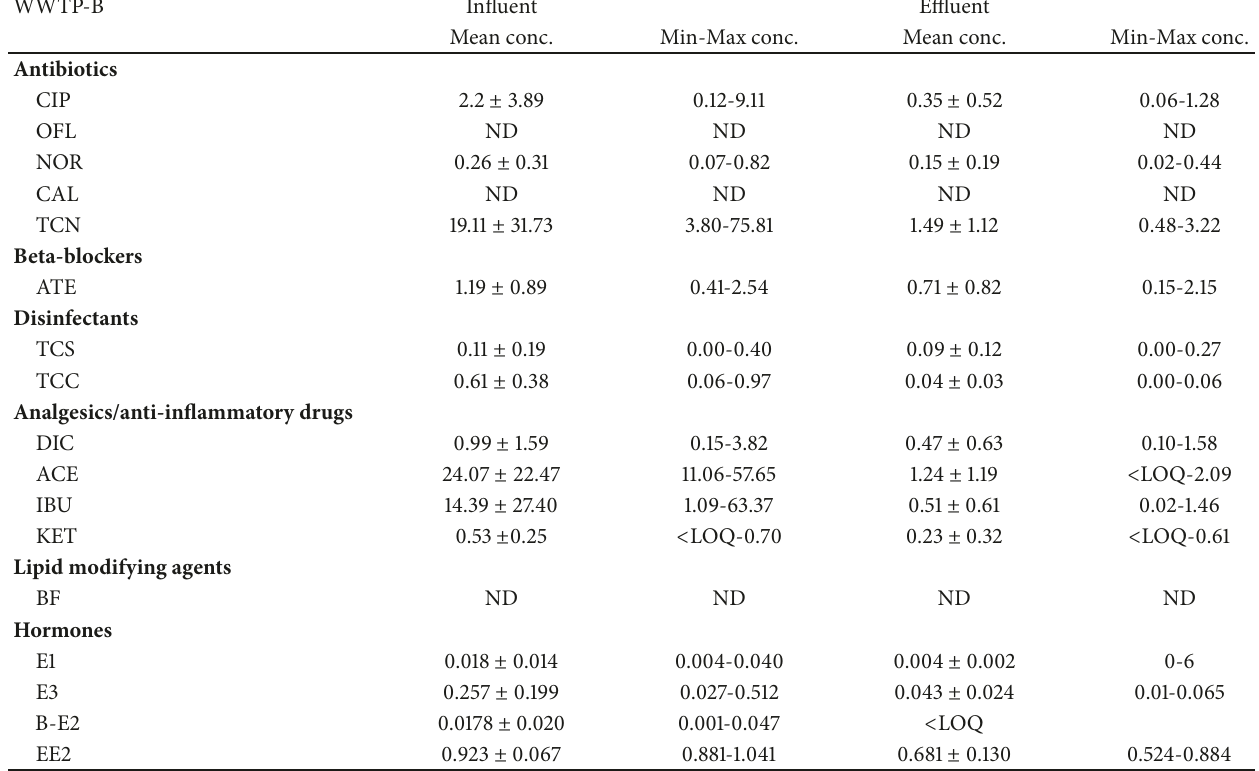
Table 7: Overall concentrations of pharmaceuticals in influents and effluents ( 𝜇 g/L) in